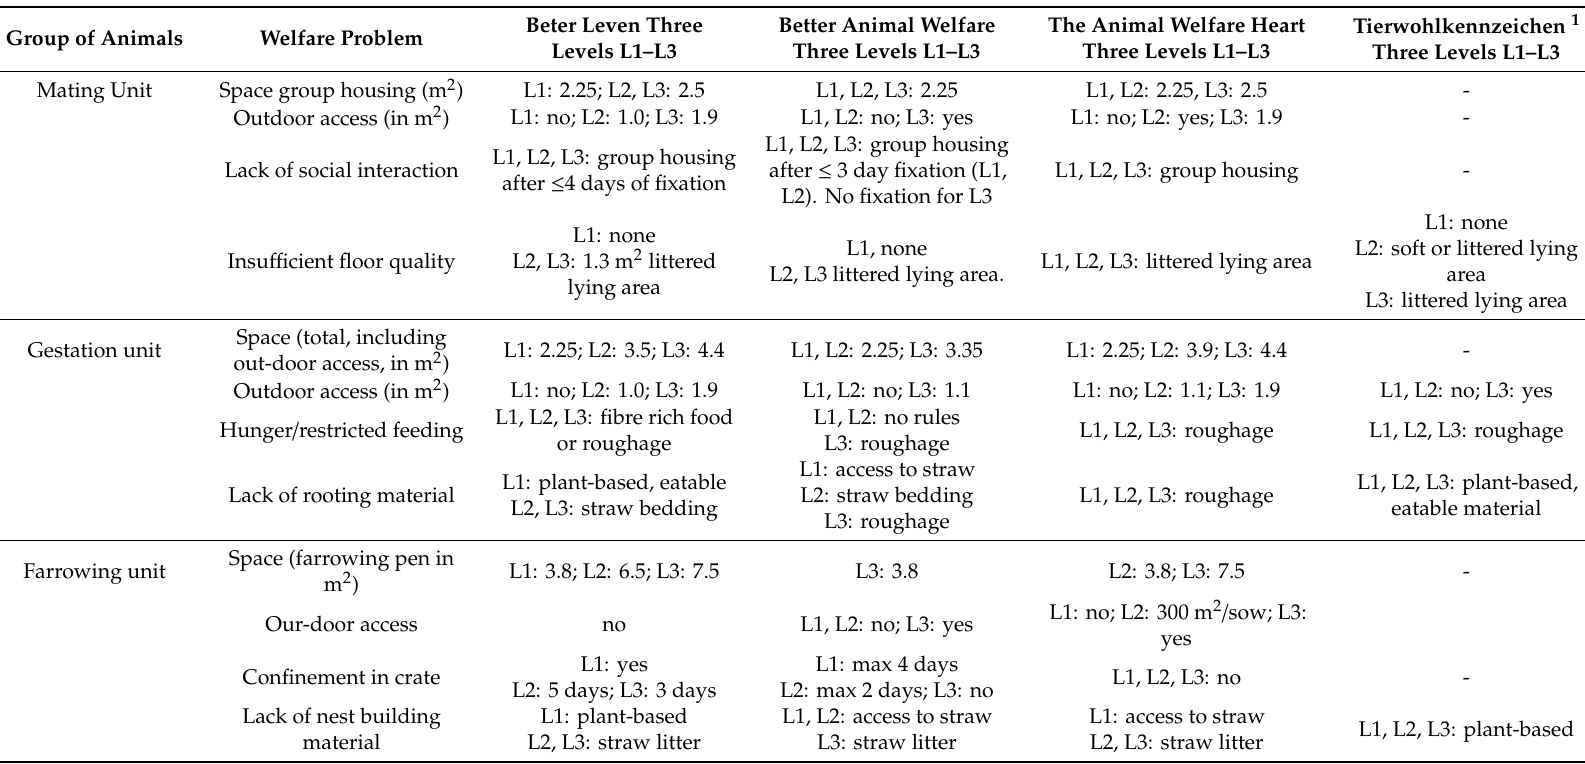
Table 1. An overview showing how the labels address the major welfare problems in pig production for sows. The labels comprise 3 levels (L), with higher levels indicative of higher